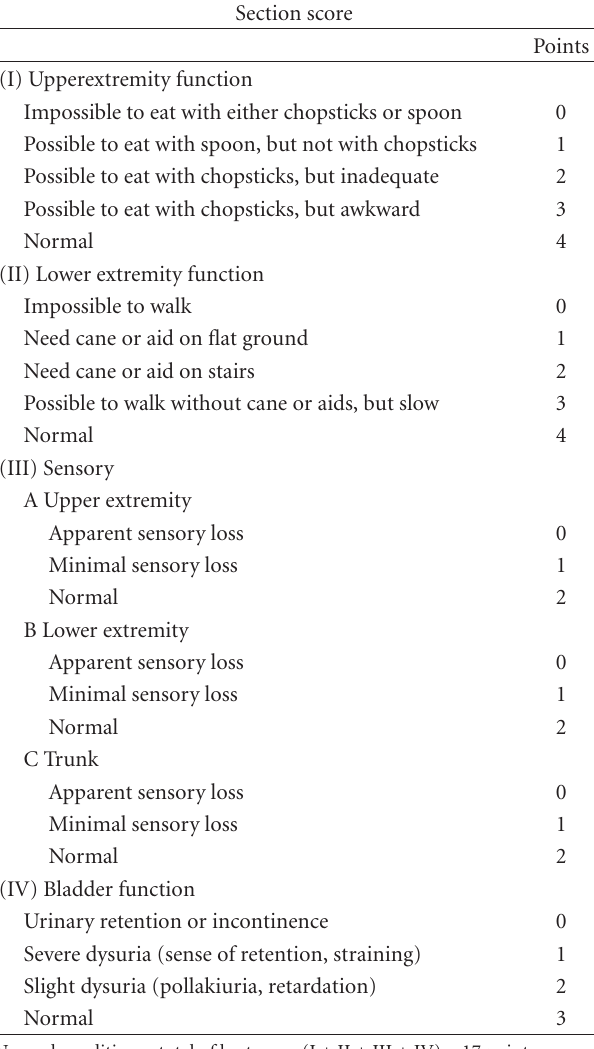
Table 1: Evaluation system for cervical myelopathy (compiled by the Japanese Orthopedic Association